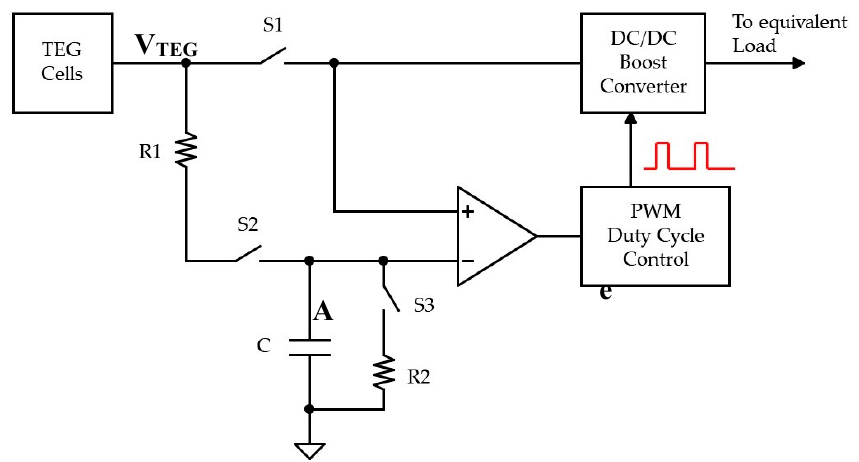
Figure 5. Adopted circuital scheme for the implemented fractional open-circuit voltage (FOCV) MPPT algorithm.